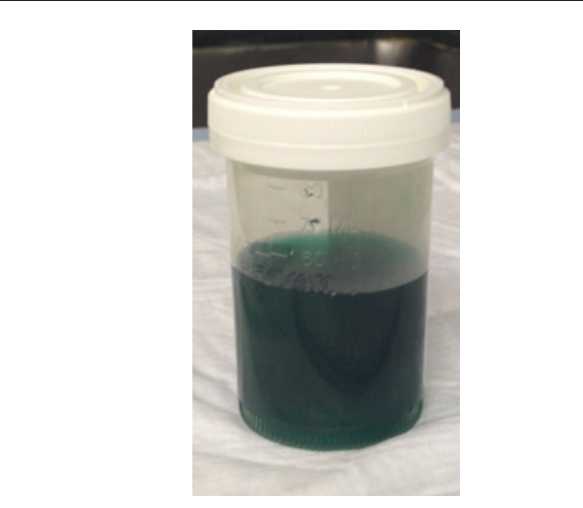
Figure. Patient’s blue urine after intragastric balloon